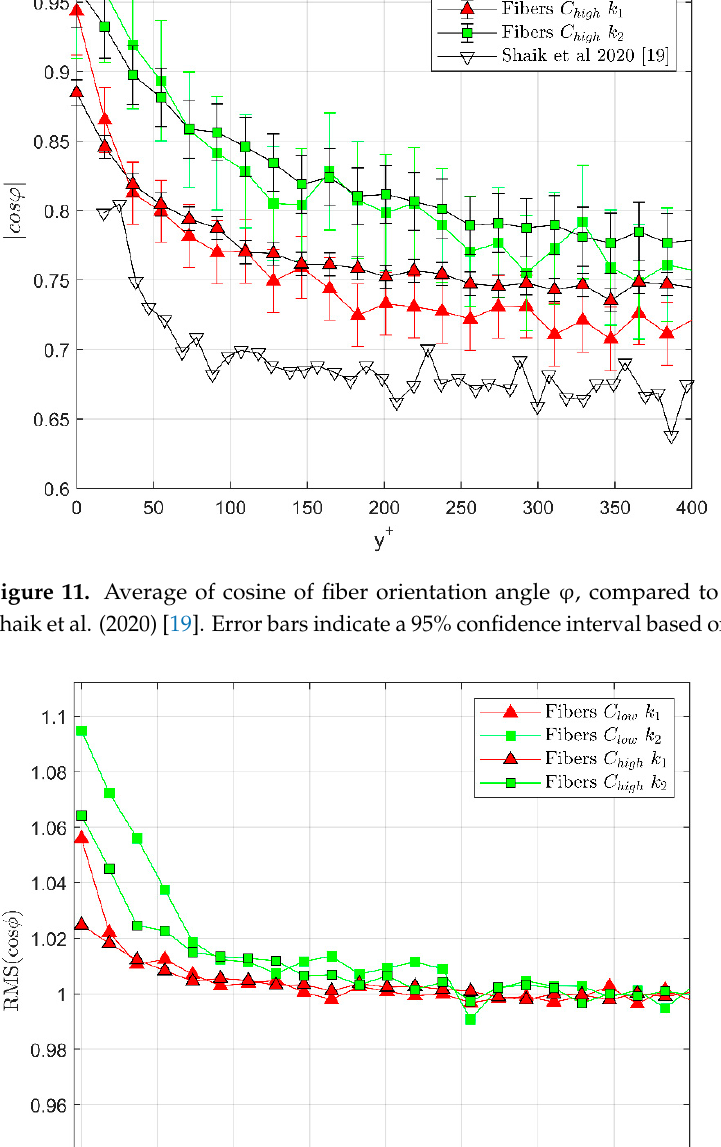
Figure 10. Relative concentration N of fiber particles normalized versus centerline concentration. Data compared to Do-Quang et al. (2014) [38].